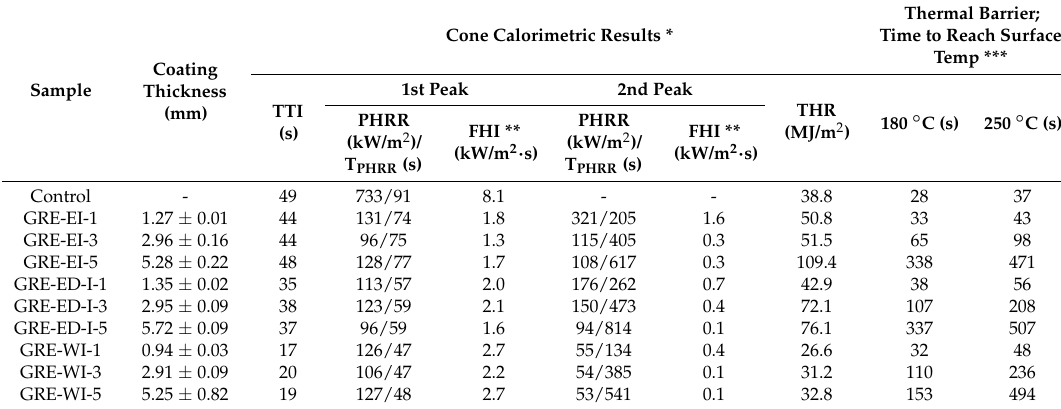
Table 1. Cone calorimetric results for different intumescent coatings of varying thicknesses on GRE composite samples, exposed to 50 kW/m 2 heat